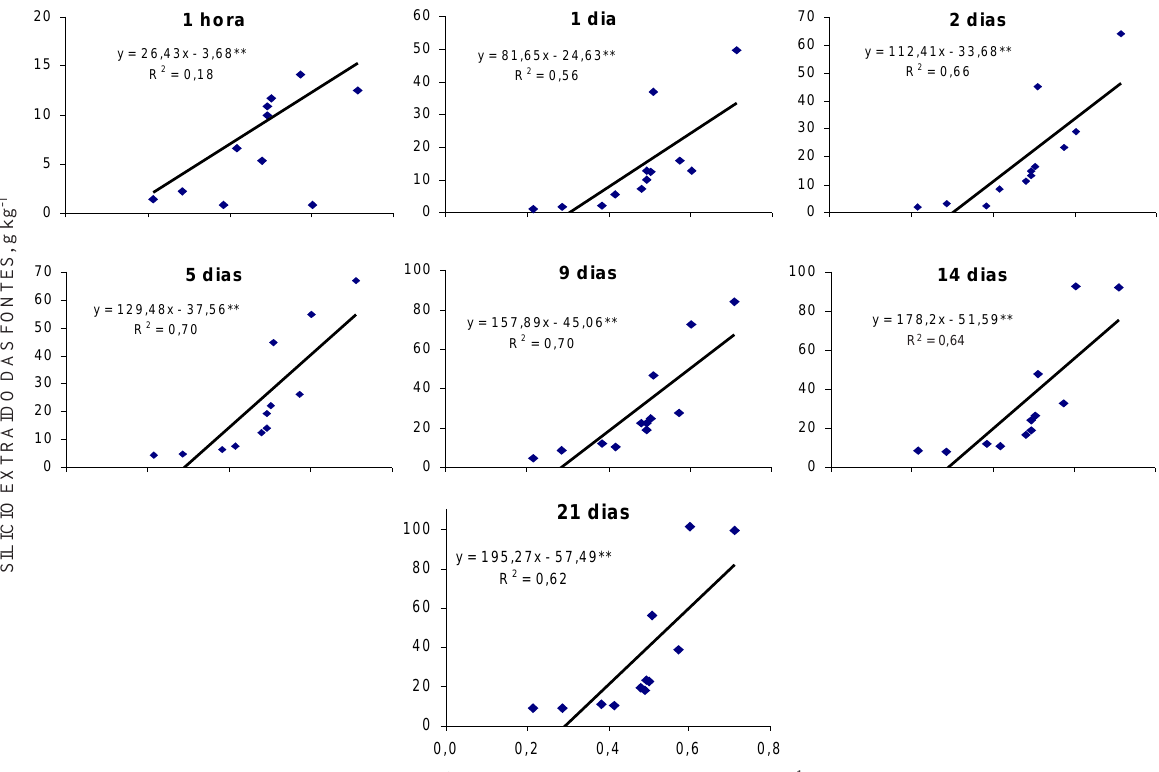
Figura 2. Correlação entre o Si extraído das fontes pelo Na acumulado na parte aérea do arroz nos diferentes tempos de contato da fonte com o extrator, após a agitação. ** significativo a 1